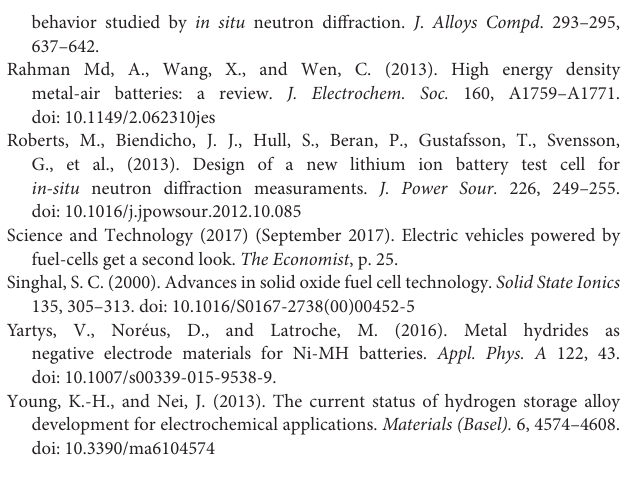
metallic electrodes in an air cathode battery in-situ . The specially designed separator module, the choice of Ni mesh as cathode and the use of deuterated aqueous electrolyte are key components to obtain neutron diffraction patterns with good signal-to-noise ratio, which may be used to extract relevant structural information such as phase stability or phase fraction as highlighted for an MH-air and a Fe-air battery,